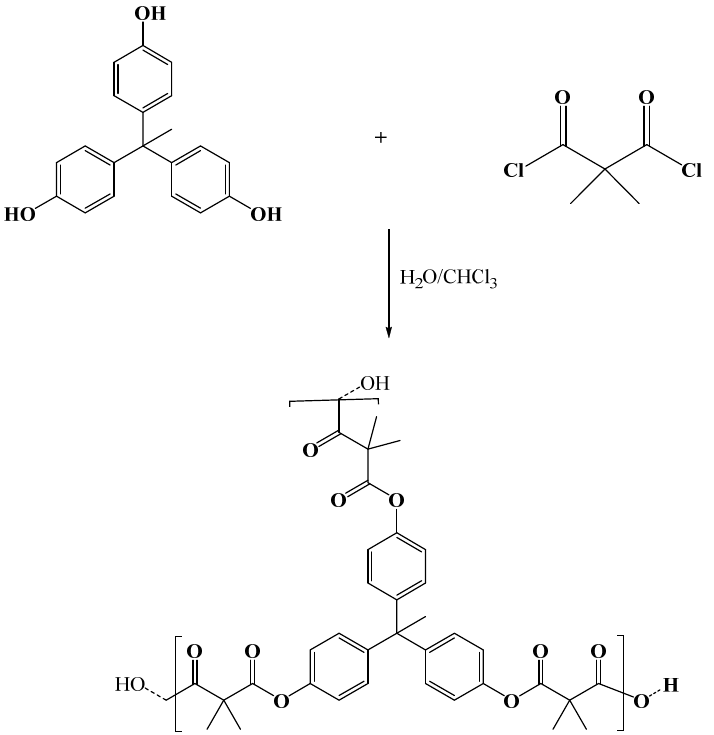
Figure 1. Synthesis of a hyperbranched polyester based on THPE.